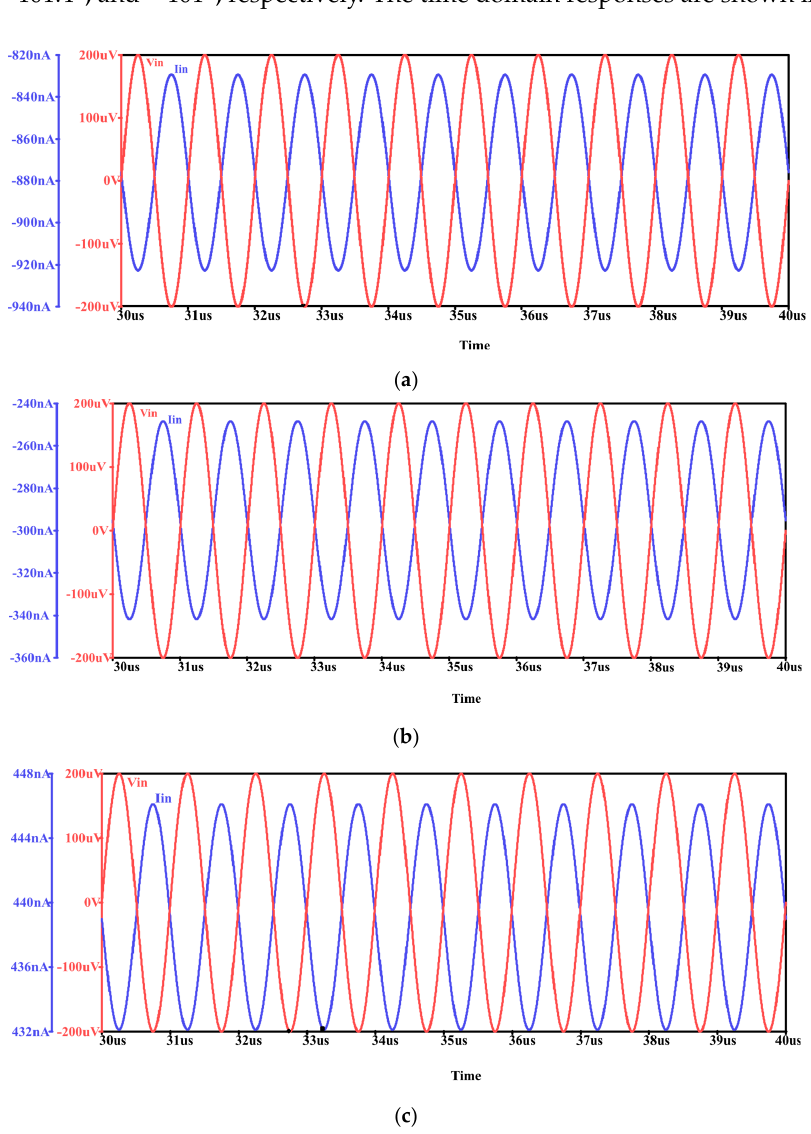
Figure 11. Time domain response of the proposed circuit ( a ) V C = − 0.9 V ( b ) V C = − 0.45 V, and ( c ) V C = 0 V. Table 3. Deviation between theoretical and simulated values at different multiplication factors, C = 10 pF and f = 100 kHz.